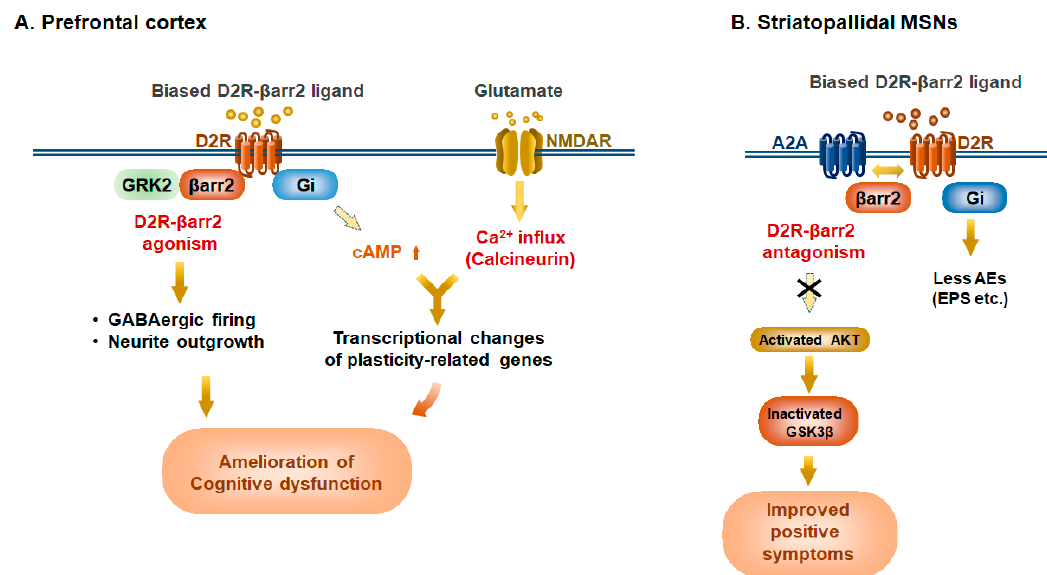
Figure 4. Potential therapeutic benefits of Selective D2R- β -arrestin2 ligands in prefrontal cortex and basal ganglia in schizophrenia. β -arrestin2 ( β arr2)-biased ligands, such as UNC9994, can act as a D2R- β arr2 agonist in the hypodopaminergic prefrontal cortex but a D2R- β arr2 antagonist on hyperdopaminergic tone of striatopallidal MSNs. ( A ) In the hypodopaminergic state in the prefrontal cortex (PFC), D2R- β arr2 ligands can act as an agonist, which evokes action potential firing of cortical GABAergic fast-spiking interneurons (FSIs) and promotes neurite outgrowth through the AKT/GSK3 β pathway. In parallel, the reduced Gi activity induces the rise of intracellular cAMP levels, resulting in the transcriptional changes of neuronal plasticity-related genes including egr-1, and Bdnf. This cAMP increase also potentiates NMDA receptor activity through cAMP/PKA, eventually leading to transcriptional changes. These events would participate in long-lasting effects on the neuronal circuit to ameliorate cognitive impairment in the disorder. ( B ) In the hyperdopaminergic state of striatopallidal MSNs, D2R- β arr2 ligands can act as antagonists, promoting heterodimerization of A2a receptor (A2A) with D2R and leading to the activation of AKT, which in turn inhibits GSK3 β activation. Meanwhile, D2R- β arr2 ligands have no effect on the Gi/o pathway. These events would ameliorate positive symptoms of schizophrenia with less adverse events (AEs) such as extrapyramidal symptoms